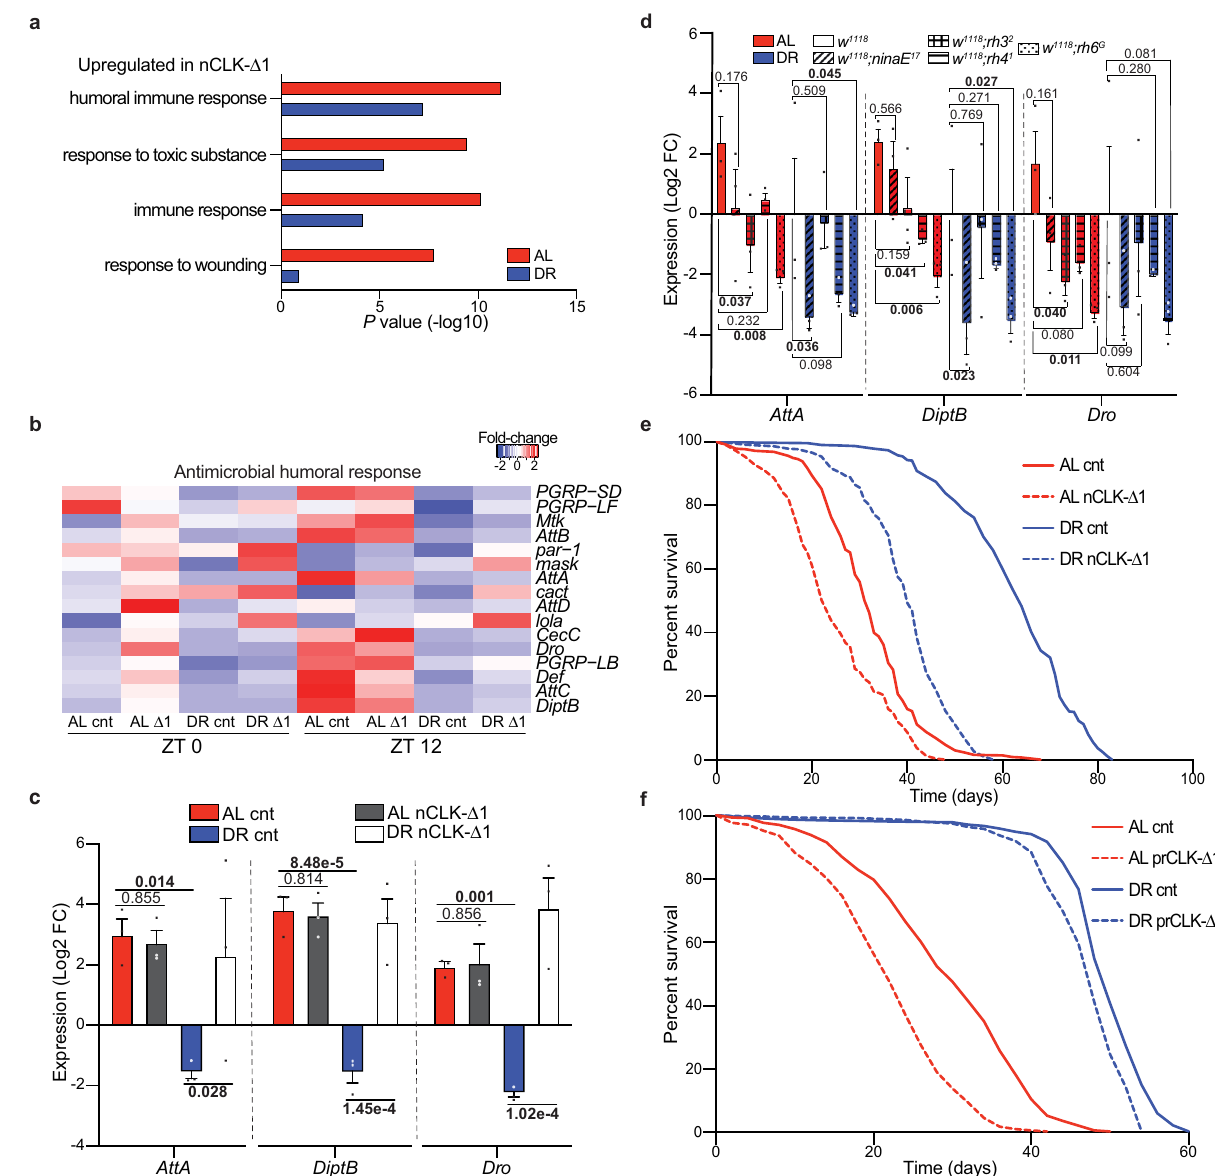
Fig. 4 nCLK- Δ 1 fl ies display elevated immune responses and shortened lifespan. a GO enrichment scores corresponding to upregulated in fl ammatory genes in heads from RNA-Seq of nCLK- Δ 1 vs controls. P- values were calculated with hypergeometric distribution ( fi ndGO.pl, HOMER) with no adjustment for multiple-hypothesis testing. b Heatmap of normalized RNA-seq expression corresponding to the gene-ontology category “ Antimicrobial humoral responses ” (GO:0019730) in nCLK- Δ 1 and controls. c Relative expression of AMP genes ( attA , diptB , and dro ) calculated by RT-qPCR with mRNA isolated from nCLK- Δ 1 bodies. Results are plotted as average Log2 fold-change in expression calculated by the ΔΔ -Ct method, normalized to DR vehicle-treated control samples, as well as the housekeeping gene rp49 ± SEM ( n = 3 biologically independent cohorts of fl ies, N = 30 fl ies per cohort). P -values were determined by two-tailed Student ’ s t -test (unpaired), comparing Log2 fold-changes in expression. d Relative mRNA expression of immune genes ( attaA , diptB , and dro ) calculated by RT-qPCR with mRNA isolated from bodies of w 1118 and rhodopsin mutant fl ies housed in 12:12 h LD. Results are plotted as average Log2 fold-change in expression calculated by the ΔΔ -Ct method normalized w 1118 DR control samples as well as rp49 ± SEM ( n = 3 biologically independent cohorts of fl ies, N = 30 fl ies per cohort). P- values were determined by two-tailed Student ’ s t -test (unpaired), comparing Log2 fold-changes in expression. e Kaplan – Meyer survival analysis of nCLK- Δ 1 fl ies (Elav-GS-GAL4 > UAS-CLK- Δ 1) reared at 25 °C. Survival data are plotted as an average of three independent lifespan repeats. Control fl ies (vehicle-treated): AL N = 575, DR N = 526; nCLK- Δ 1 fl ies (RU486 treated): AL N = 570, DR N = 565. Survival data are plotted as an average of three independent lifespan repeats. Control fl ies: AL N = 599, DR N = 501; prCLK- Δ 1 fl ies: AL N = 513,